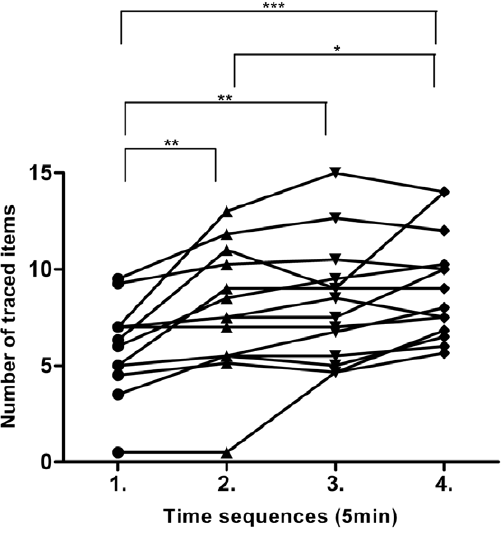
Figure 1. Behavioral results of task ML sighted . Lines indicate individual subjects’ performance (number of traced words/shapes) over time. *=p , 0.05. **=p , 0.01. ***=p , 0.001.